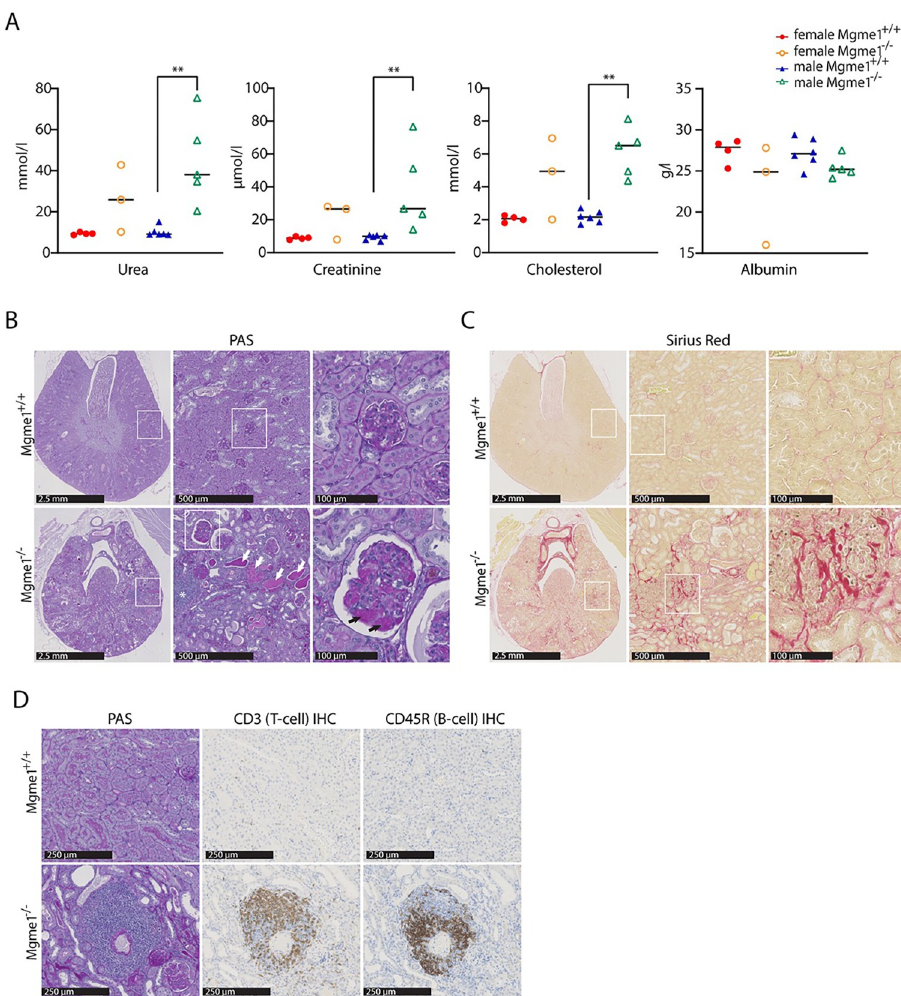
Fig 5. Mgme1 -/- mice display altered renal function and a severe nephropathy (A) Plasma urea, creatinine, cholesterol and albumin levels of ad libitum fed mice at 68 weeks of age; n = 4 WT and 3 Mgme1 -/- females and 6 WT and 5 Mgme1 -/- males. The median is shown as a line. �� P � 0.01 (B) Representative pictures of PAS (Periodic acid- Schiff) stainings of kidney sections from control and Mgme1 -/- mice. Multifocal hyaline proteinaceous casts (indicated with white arrows) and lymphocytic immune infiltrates (indicated with an asterisk) were found in the kidneys of Mgme1 -/- animals (lower central panel). PAS-positive mesangial matrix expansion (indicated with black arrows) was obvious in many glomeruli of knockout mice as shown at higher magnification (lower panel, right). (C) Representative pictures of Sirius Red stainings at different magnifications show pronounced tubulointerstitial fibrosis in the kidneys of knockout mice. (D) Immune infiltrates in the kidneys of Mgme1 -/- animals were composed mainly by T and B cells, as demonstrated by CD3 and CD45R/B220 immunohistochemistry,